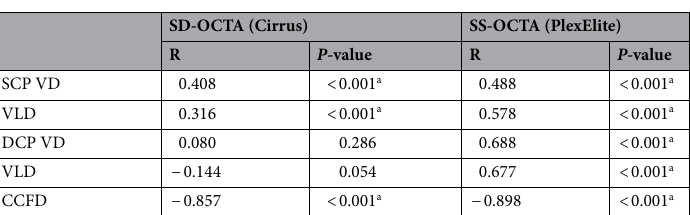
Table 2. The correlations between signal strength and quantitative flow parameters. CCFD choriocapillaris flow deficits, DCP deep capillary plexus, OCTA optical coherence tomography angiography, SCP superficial capillary plexus, SD spectral-domain, SS swept-source, VD vessel density, VLD vessel length density. a P < 0.05 was considered statistically significant. R is Pearson correlation